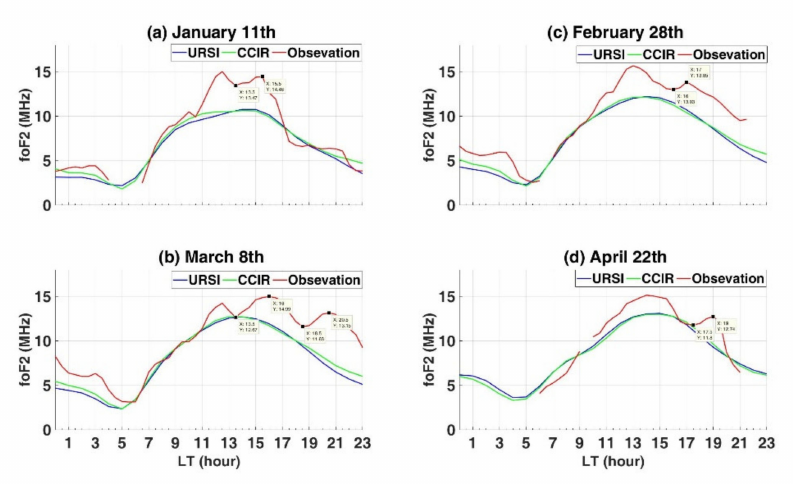
Figure 2. The diurnal variations of fo F2 in the days that bite-out